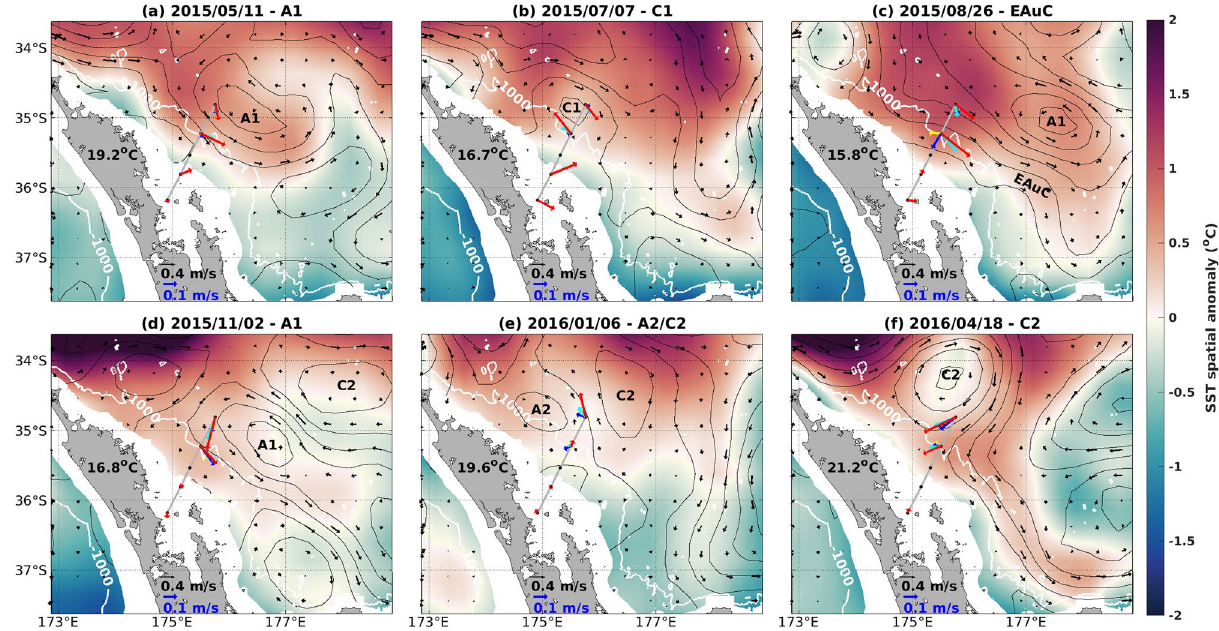
Figure 2. Maps of SST spatial anomaly (coloured shade) (mean value in black), geostrophic (black arrows) and daily averaged in situ velocities (coloured arrows as in Fig. 1a) on ( a ) 11/5/2015, ( b ) 7/7/2015, ( c ) 26/8/2015, ( d ) 2/11/2015, ( e ) 6/1/2016, and ( f ) 18/4/2016 showing the mesoscale structures A1, C1, EAuC, A1, A2/C2, and C2, respectively. The maps were generated with m_map (http:// www. eos. ubc. ca/